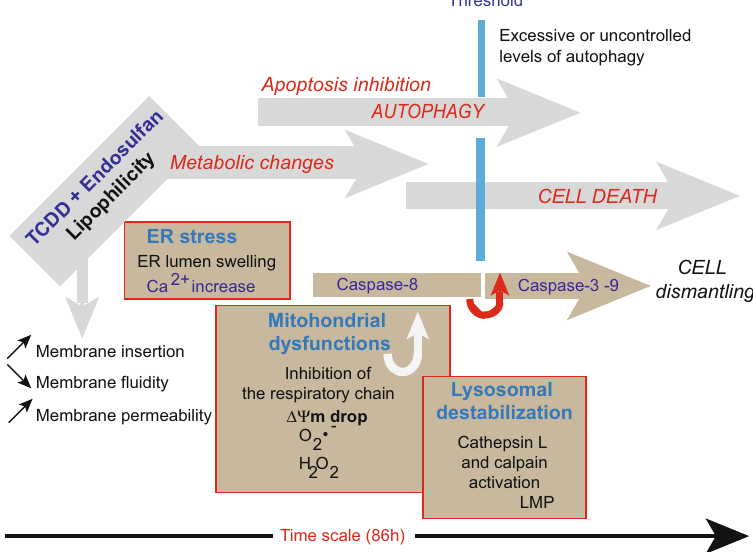
Figure 10. Schematic representation of the various events involved in the TCDD + endosulfan signalization. TCDD and endosulfan which are very lipophilic substances penetrate the cells and interact with all the membrane compartments. They provoke an ER stress and lysosomal membrane destabilization. Calcium release from the ER enter the mitochondria and alter the electron transport chain, resulting in a ΔΨ m drop and superoxide generation. Altered mitochondria are taken up by mitophagy. The lysosomal pathway also converges towards mitochondria since calpain and cathepsin are susceptible of Caspase-8 activation and Bid cleavage. Huge autophagic processes are induced in parallel to cell death events until Beclin-1 is cleaved and death dominates. An inhibition of autophagy (by Bafilomycin A1) leads to a more pronounced cell